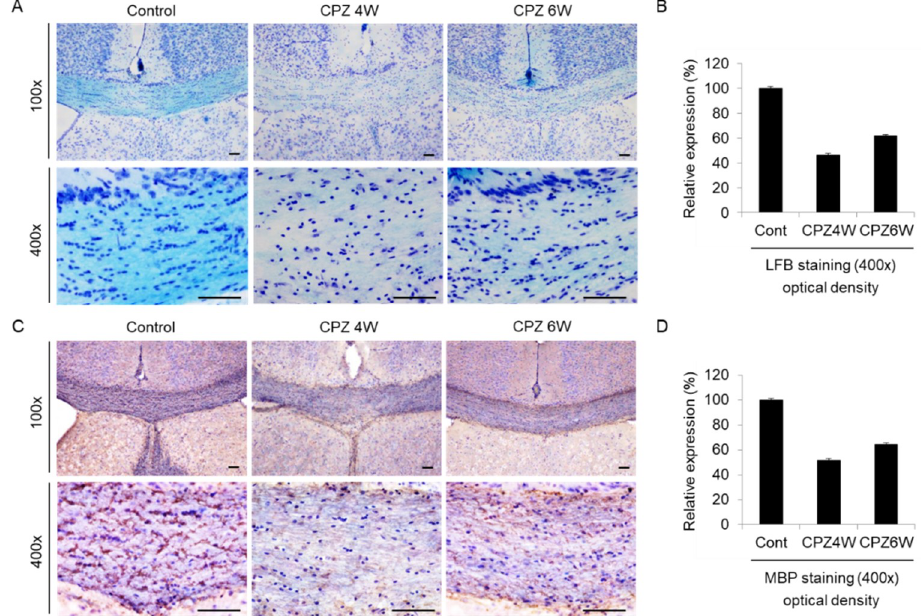
Figure 5. Induction of demyelination in cuprizone-fed mice. ( A ) Luxol fast blue (LFB)/Cresyl Echt Violet staining in coronal slices of the cuprizone-fed and control groups in the corpus callosum. Myelinated fibers are shown in blue, and Nissil substance and nerve cells in violet. Lithium carbonate indicates differentiation, and Cresyl Echt Violet is a counterstain. Scale bar: 50 μm. ( C ) Myelin basic protein (MBP) immunostaining in coronal slices of the cuprizone-fed and control groups in the corpus callosum. Control mice display a normally myelinated corpus callosum. Maximal demyelination is observed after 4 weeks on a cuprizone diet, and the recovery of demyelination is weakly observed after 6 weeks on a cuprizone diet. Scale bar: 50 μm. For each staining, three sections per animal were used and a total of two mice were tested each group. The staining was done at least twice each. ( B , D ) The integral optical density of LFB or MBP revealed using i -Solution software.